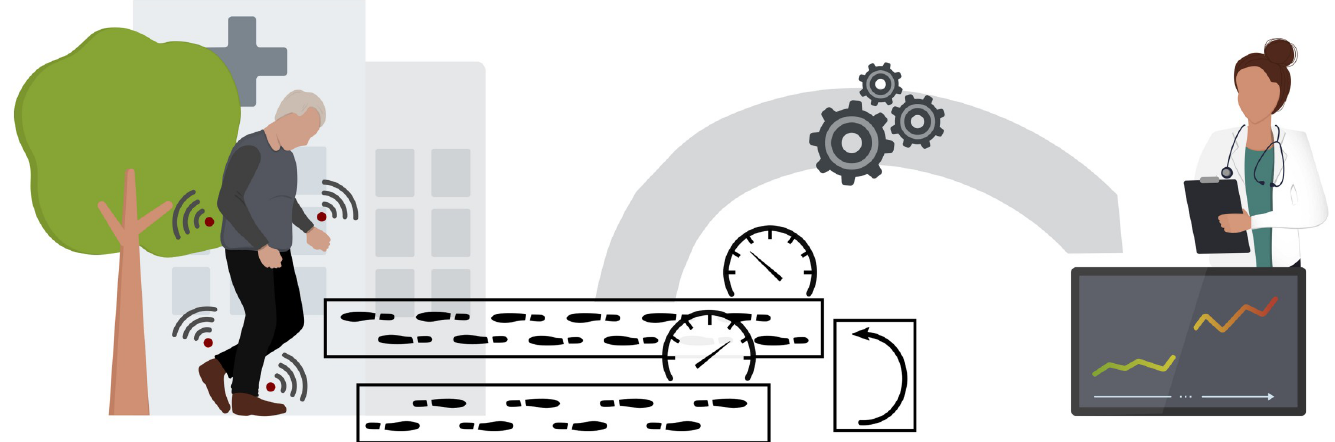
Fig 1. Real-world walking assessment. Monitoring of real-world mobility using wearable sensors requires the definition of essential components of unsupervised purposeful walking, such as walking bouts and turnings. The aggregated walking bouts at different speed levels yield digital mobility outcomes which can characterize clinically relevant changes in mobility